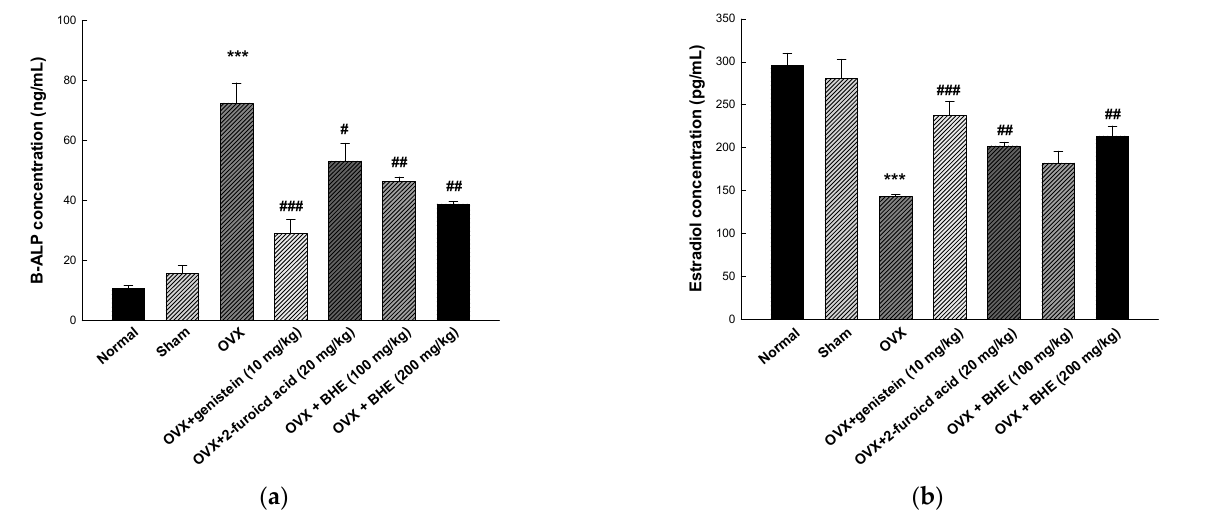
Figure 4. Effects of Benincasa hispida extracts (BHE, HR1901-W) on bone formation markers in ovariectomy-induced osteoporosis mice. The concentration of ( a ) B-ALP, and ( b ) estradiol was determined using enzyme-linked immunosorbent assay (ELISA) kits. All values are expressed as the mean ± standard error of the mean (SEM). *** p < 0.001 vs. sham group; # p < 0.05, ## p < 0.01, and ### p < 0.001 vs. OVX group. BALP, bone-specific alkaline phosphatase; OVX, ovariectomy.